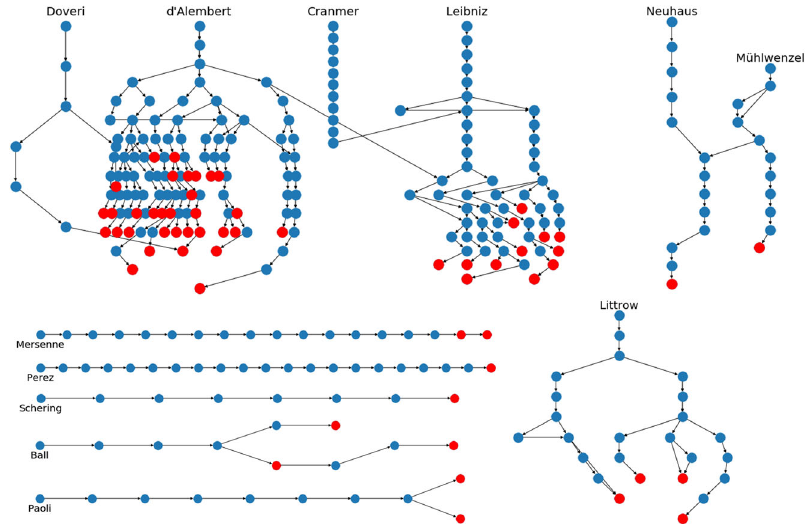
Fig. 4 Ancestral tree by principle advisor for each fi elds medalist. Each red dot denotes a Fields Medalist.